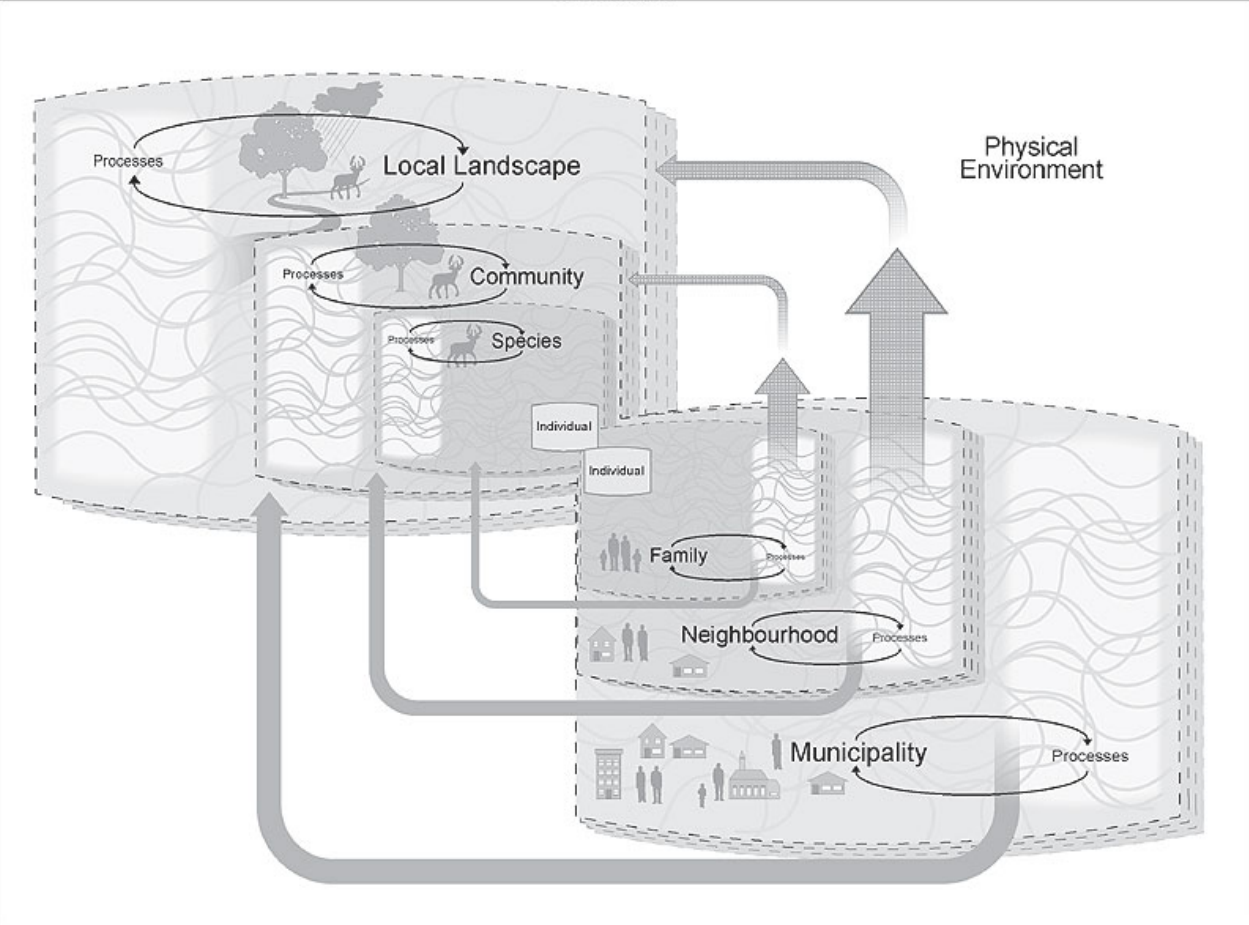
Fig. 5. An example of components and interactions over three holarchical levels beyond the individual. The "stacked deck" effect is a reminder that each level is made up of a conglomeration of defined